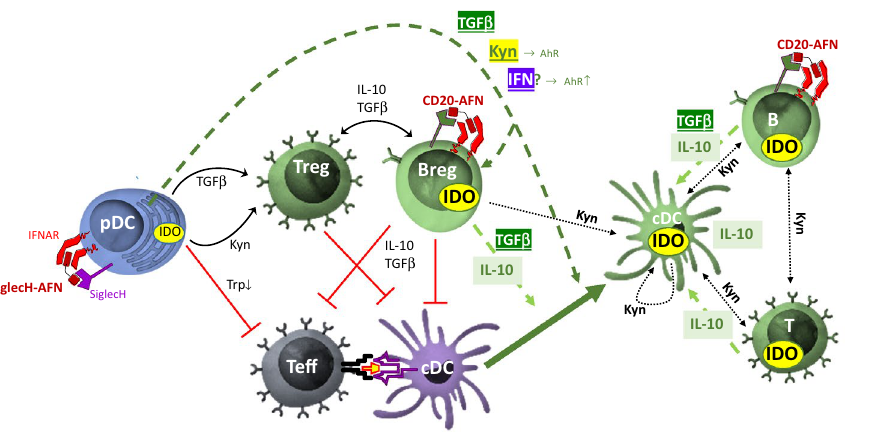
Figure 7. Graphical representation of possible tolerogenic cellular interactions induced by AFN targeting to pDCs and B lymphocytes. Targeting AFN via SiglecH to pDCs increases their TGFβ and IDO expression 18 . TGFβ and IDO-induced kynurenine synthesis can induce Tregs, while IDO-induced tryptophan catabolism inhibits Teff. Tregs and Bregs may reciprocally increase their immunosuppressive effects via IL-10 and TGFβ. Extra targeting of B lymphocytes (including Bregs) using CD20-AFN increases their IL-10 and TGFβ production (pale green dashed line). Together with TGFβ and/or kynurenines, and/or possibly type I IFN released by pDCs (dark green dashed line), these may be responsible for the substantial increase in IDO observed not only in B cells, but also in T cells and conventional cDCs. Importantly, IDO-produced kynurenine is well-known for triggering paracrine “infectious tolerance”, spreading from one cell type to another (black dotted lines) 26 , and an autocrine IDO-kyn-Ahr-IDO loop may induce long-term maintenance of the tolerogenic phenotype of cDCs (black dotted loop) 36